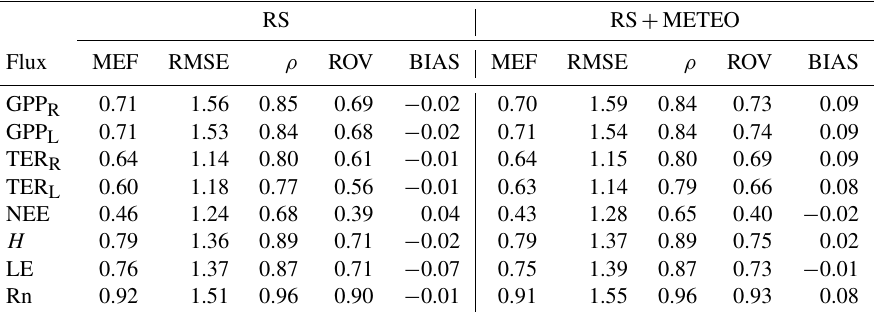
Table 3. Statistics of the accuracy of predictions of CO 2 and energy fluxes made by the ensemble median estimate based on RS and RS + METEO. For RMSE and BIAS, the reference units were gCm − 2 d − 1 and MJm − 2 d − 1 for CO 2 fluxes (GPP, TER and NEE) and energy fluxes ( H , LE and Rn), respectively.